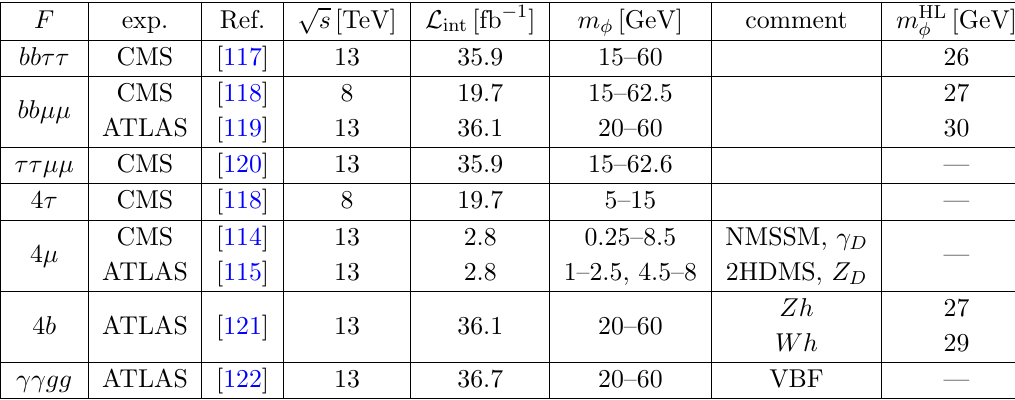
Table 2 . Summary of the implications of exotic Higgs decay searches on the relaxion parameter space. The columns show the (cid:12)nal state F of the search channel pp ! h ! (cid:30)(cid:30) ! F ; the experiment (ATLAS, CMS) with reference; the data set collected at a center-of-mass energy an integrated luminosity of L int , the mass range of m (cid:30) probed by the speci(cid:12)c channel, comments (on the production mode and model-dependence of some bounds); estimate of the asymptotically vertical upper bound on m (cid:30) of the HL-LHC projection (if any). For comparison, CEPC is